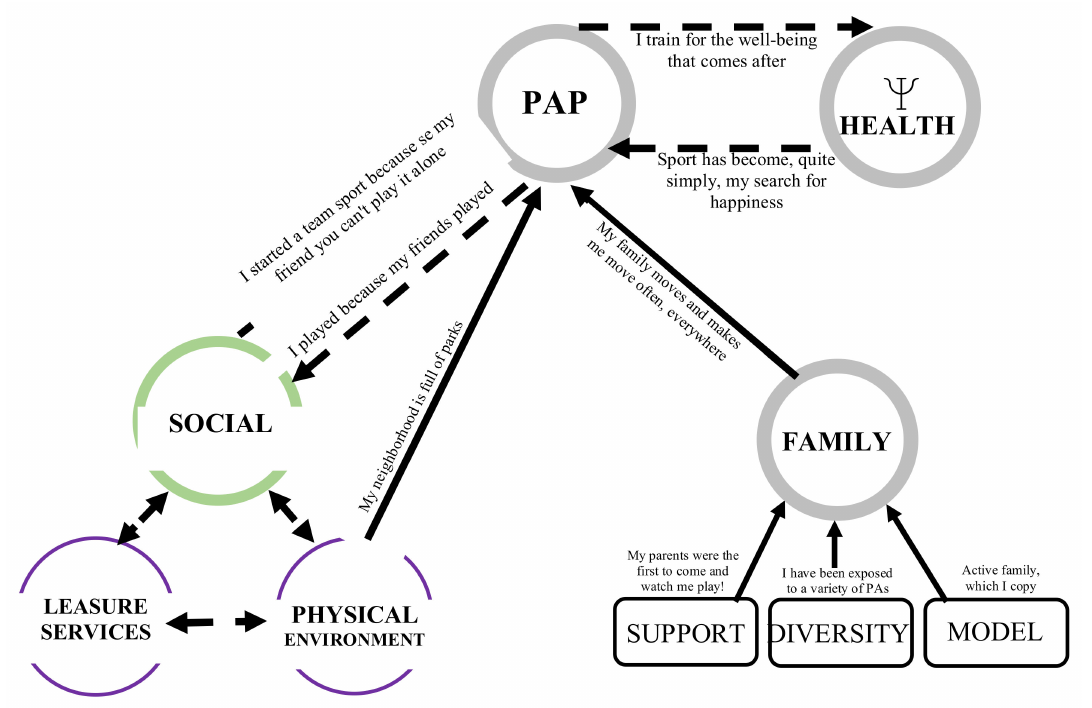
Figure 2. The social environment as a winning condition for the adoption and maintenance of healthy lifestyle habits.